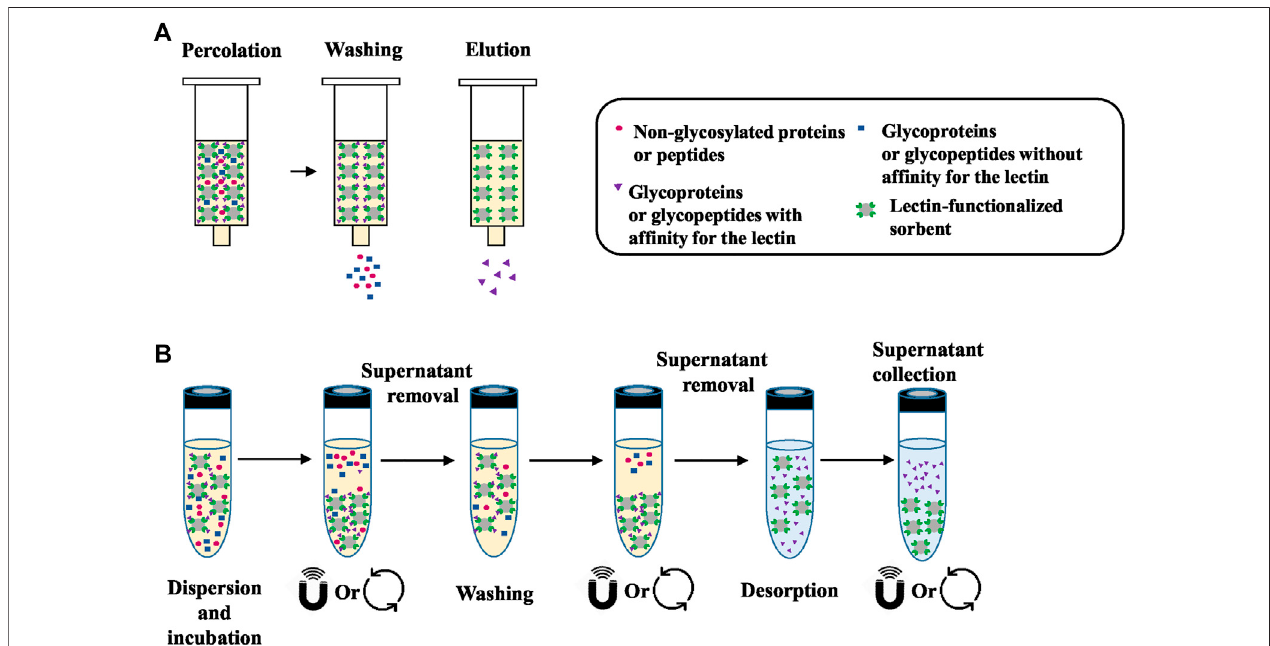
FIGURE 1 | (A) General work fl ow of lectin SPE. Initially the sample, which is a mixture of molecules with and without af fi nity for the lectin sorbent, is percolated through the cartridge. Percolation is followed by washing of the components that do not have af fi nity and fi nally elution of the target glycoproteins or glycopeptides by disrupting the lectin-sugar bonds. (B) General work fl ow of lectin dSPE. Initially the sample is mixed “ in solution ” with the lectin-functionalized sorbent in order to capture thosemoleculesthathaveaf fi nitywiththelectin.Aftercentrifugationortheapplicationofamagnetic fi eld,thecompoundsthatdonothaveaf fi nityarecollectedfrom the supernatant. Additional washing steps can be implemented to remove all non-retained compounds. The fi nal desorption of target glycoproteins or glycopeptides is performed under the appropriate conditions (see Table 3 ).